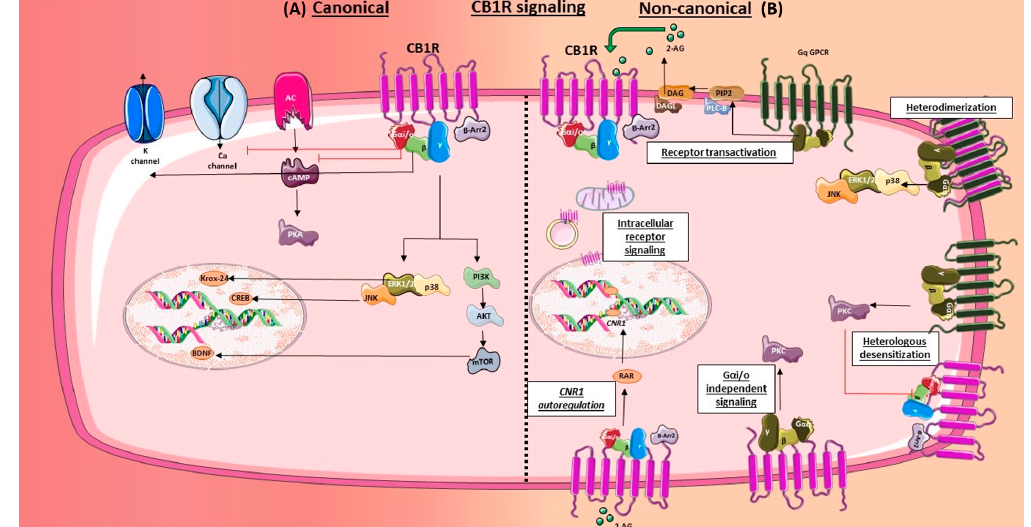
Figure 3. Canonical and non-canonical signaling of CB1R. ( A ) Canonically, CB1R activation results in coupling of pertussis toxin (PTX)-sensitive G-protein (G α i / o ), and the activation of GIRK and inhibition of calcium channels. CB1Rs also activate MAPKs, such as ERK1 / 2 and JNK, which result in the subsequent induction of Krox-24 and CREB respectively. In addition, CB1R stimulation also leads to the downstream activation of PI3K / AKT / mTOR pathway, which further results in the transcription of BDNF. ( B ) The CB1R is also involved in non-canonical signaling. G α q / 11 GPCR-mediated-mobilization of endocannabinoids, and subsequent activation of the CB1R in an autocrine or paracrine fashion (Receptor transactivation). The CB1R has also been shown to dimerize with other GPCRs resulting in